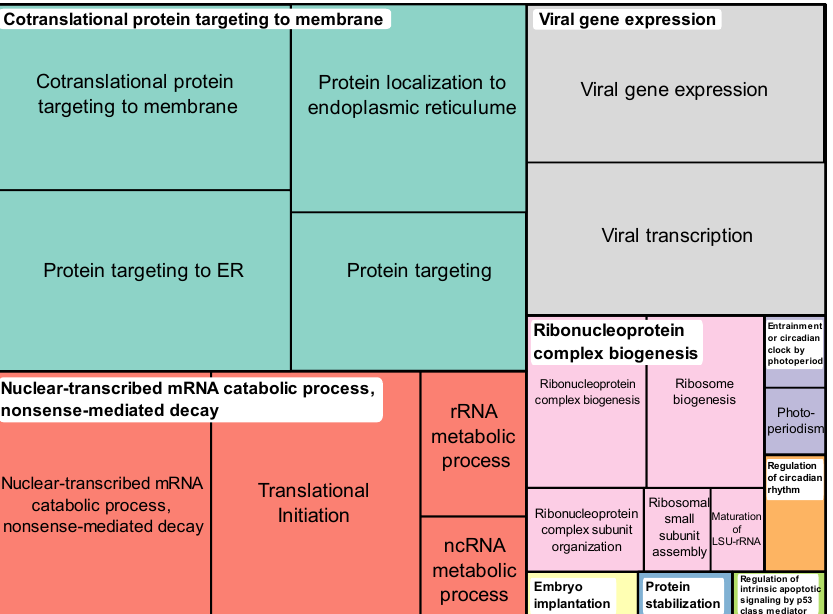
Figure 3. Over-represented Gene Ontology, biological process (GO:BP) terms in BOLD-100 sensitivity associated genes summarized by semantic similarity. Over-represented GO:BP terms ( n = 38) were grouped and summarized via a treemap using REVIGO . The coloring of the individual tiles in the treemap represents family groupings based on term similarity while the size represents the size of the GO term in the database.